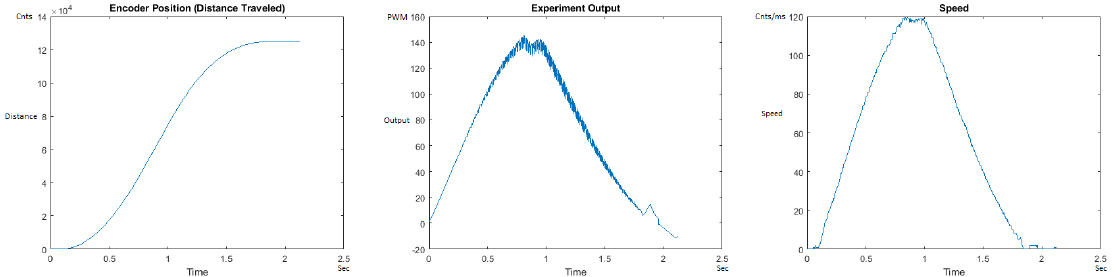
Figure 15. Encoder position, output and speed plots for PID++ UP operation— Vmax 120 cnts/ms, Adesired 0.040 cnts/ms 2 — 10 g.